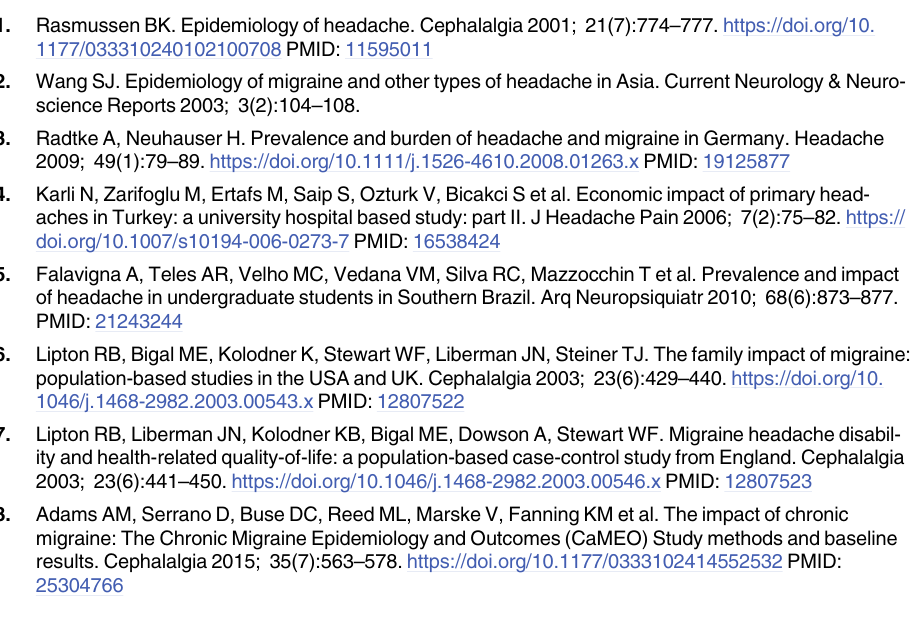
S2 Table. Search strategy. S3 Table. Quality ratings of included